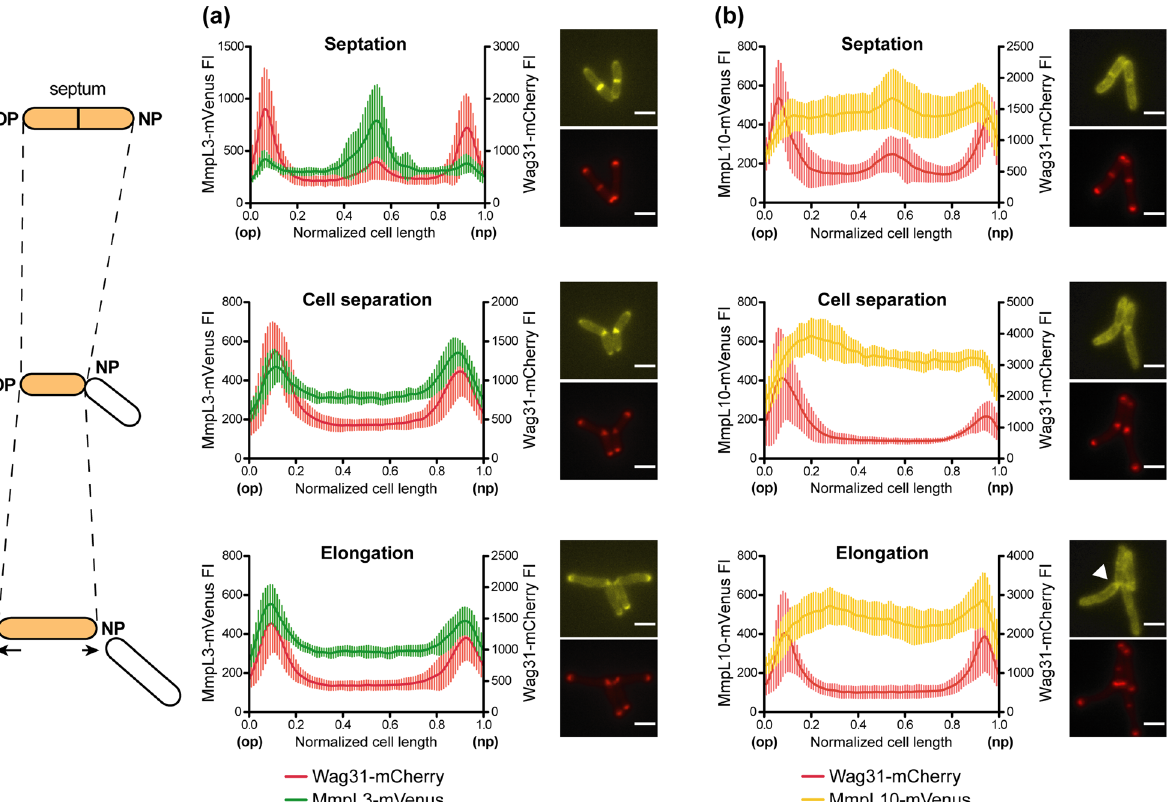
Figure 2. Fluorescence intensities of MmpL3-mVenus, MmpL10-mVenus and Wag31-mCherry over the long axis of M. smegmatis cells. Plot profiles are represented as in Fig. 1 and calculated on snapshot images obtained from bacteria that expressed either MmpL3-mVenus in combination with Wag31-mCherry (WT/pNL3Wag, panel ( a ) or MmpL10-mVenus in combination with Wag31-mCherry (PMM223/pNL10Wag, panel ( b ) at three stages of the mycobacterial cell cycle i.e. septation, cell separation (V-snapping), elongation. For each stage of the cell cycle: n > 15 for WT/pNL3Wag and n > 10 for PMM223/pNL10Wag. Vertical lines represent the standard deviations of the mean fluorescence at each position along the cell axis. Representative images of M. smegmatis cells expressing either MmpL3-mVenus/Wag31-mCherry or MmpL10-mVenus/Wag31-mCherry are shown on the left of graphs for each stage of the cell cycle (Scale bar, 2 μm). op old pole, np new pole. The white arrowhead shows the accumulation of MmpL10-mVenus at the new cell poles after cell